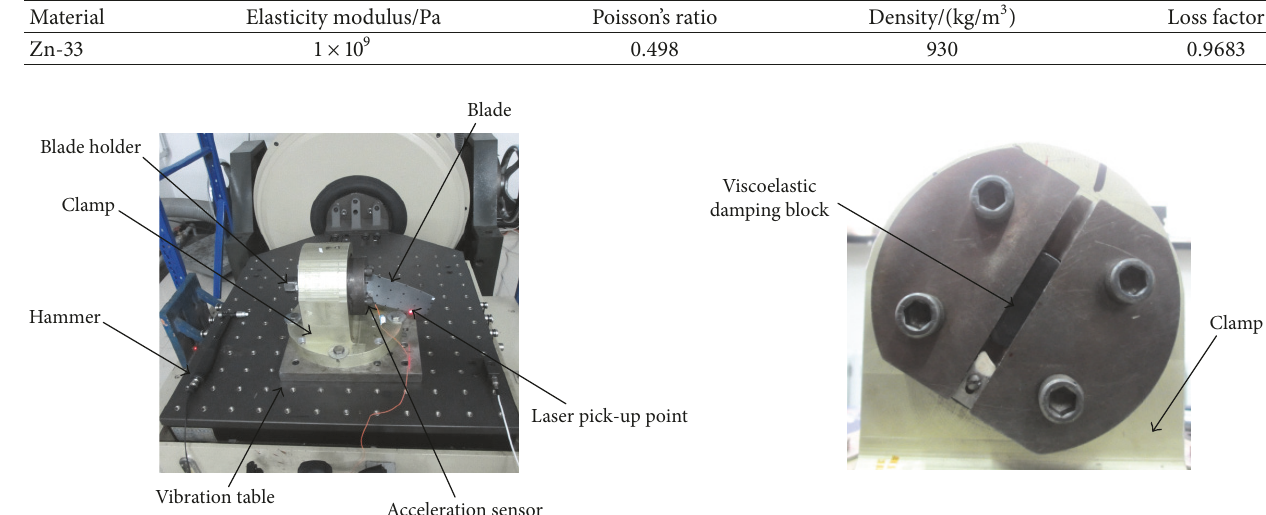
Table 1: Material parameters of the viscoelastic damping block.